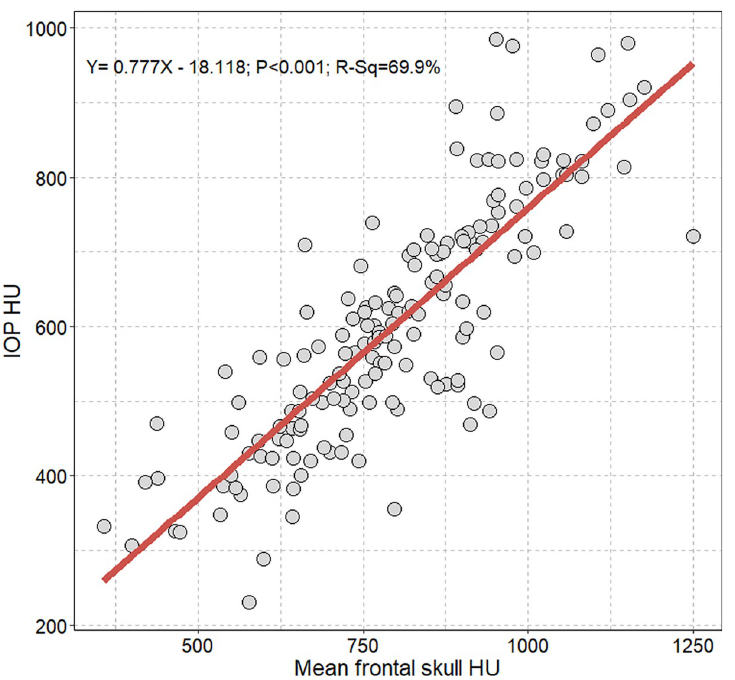
Fig 2. Scatterplot with linear regression line showing the association between mean frontal skull HU and IOP HU values. HU = Hounsfield unit; IOP = internal occipital protuberance. https://doi.org/10.1371/journal.pone.0232631.g002 and 625.5 in the non-SDHC group and 507.3 in the SDHC group. The boxplot graphically depicts significantly lower mean frontal skull and IOP HU values in the SDHC group than in the non-SDHC group (Fig 3A and 3B).